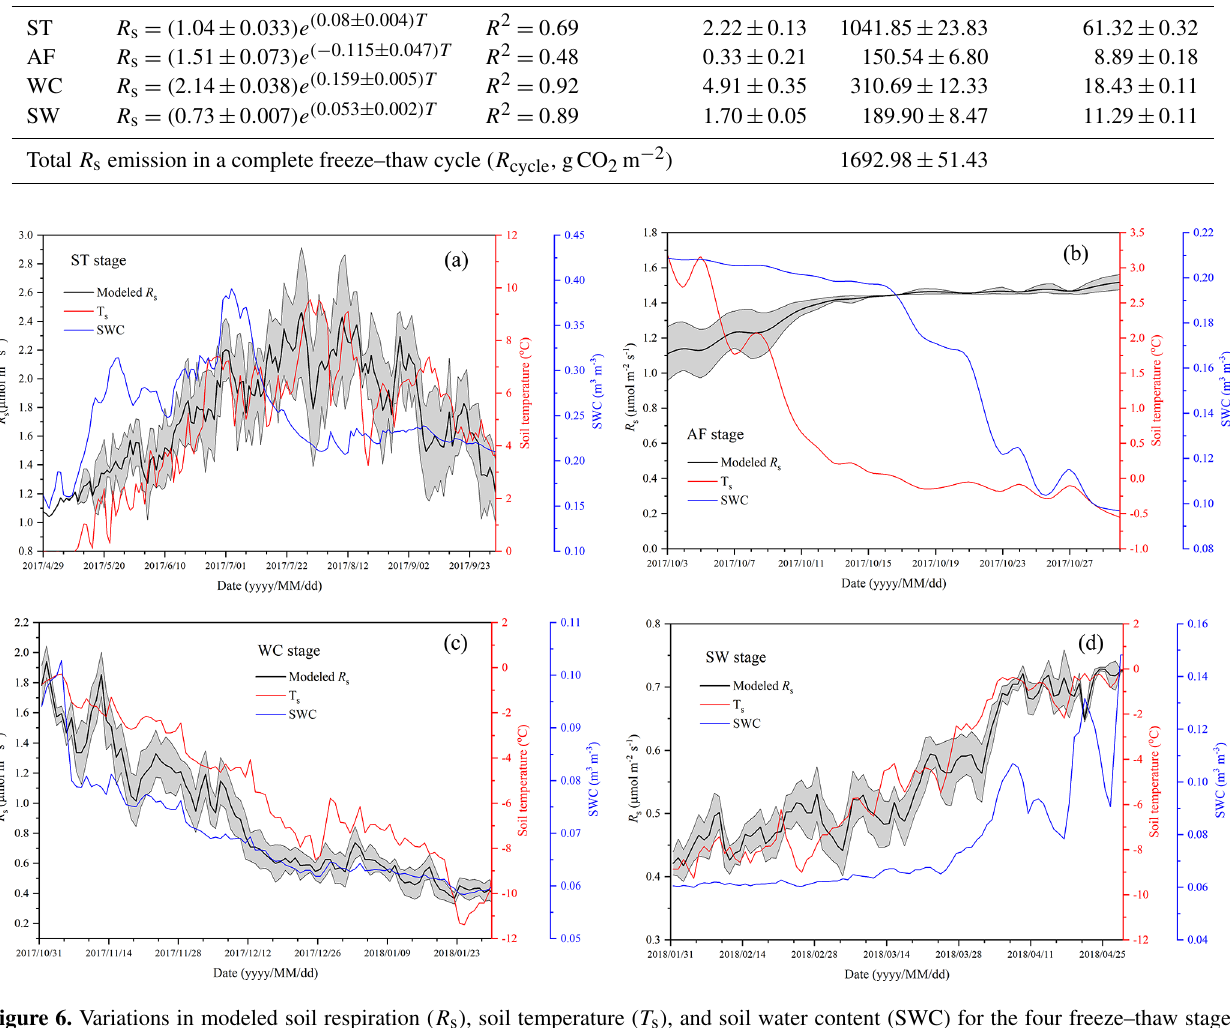
Figure 6. Variations in modeled soil respiration ( R s ), soil temperature ( T s ), and soil water content (SWC) for the four freeze–thaw stages comprising ST (a) , AF (b) , WC (c) , and SW (d) in a complete freeze–thaw cycle from later April 2017 to late April 2018. The SWC unit stands for water volume per total soil volume. The error band of modeled R s stands for the 95% confidence